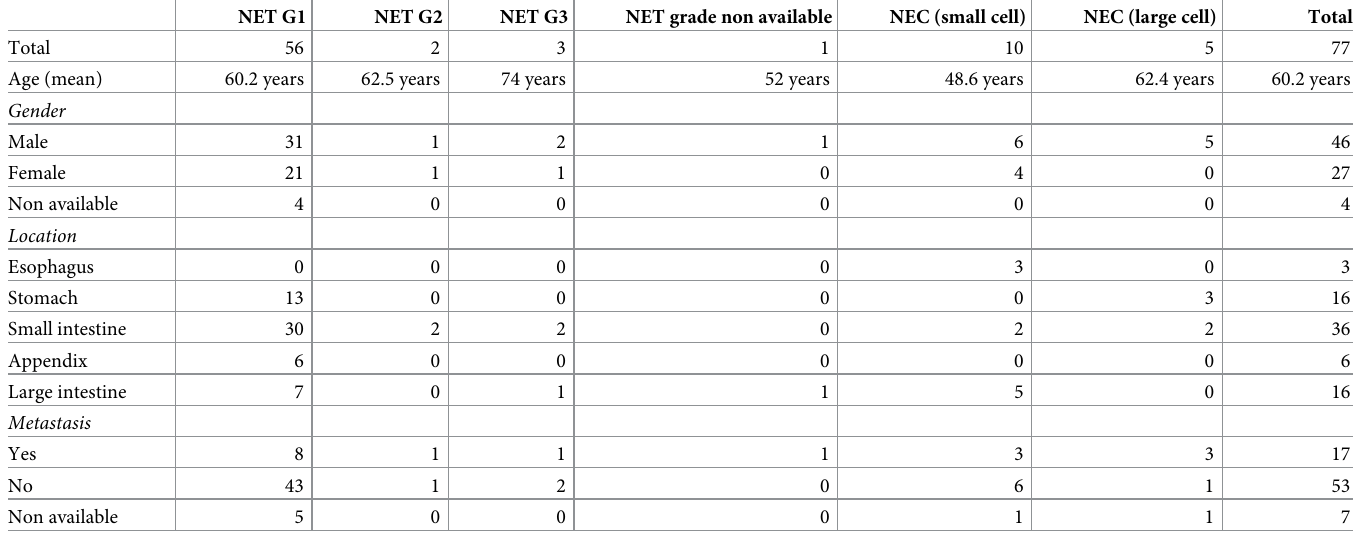
Table 1. Characteristic of patients with